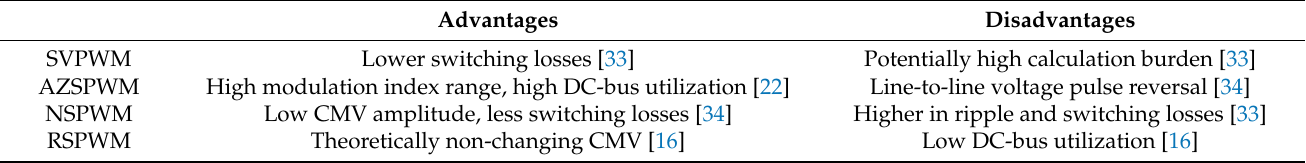
Table 1. Advantages and disadvantages of different